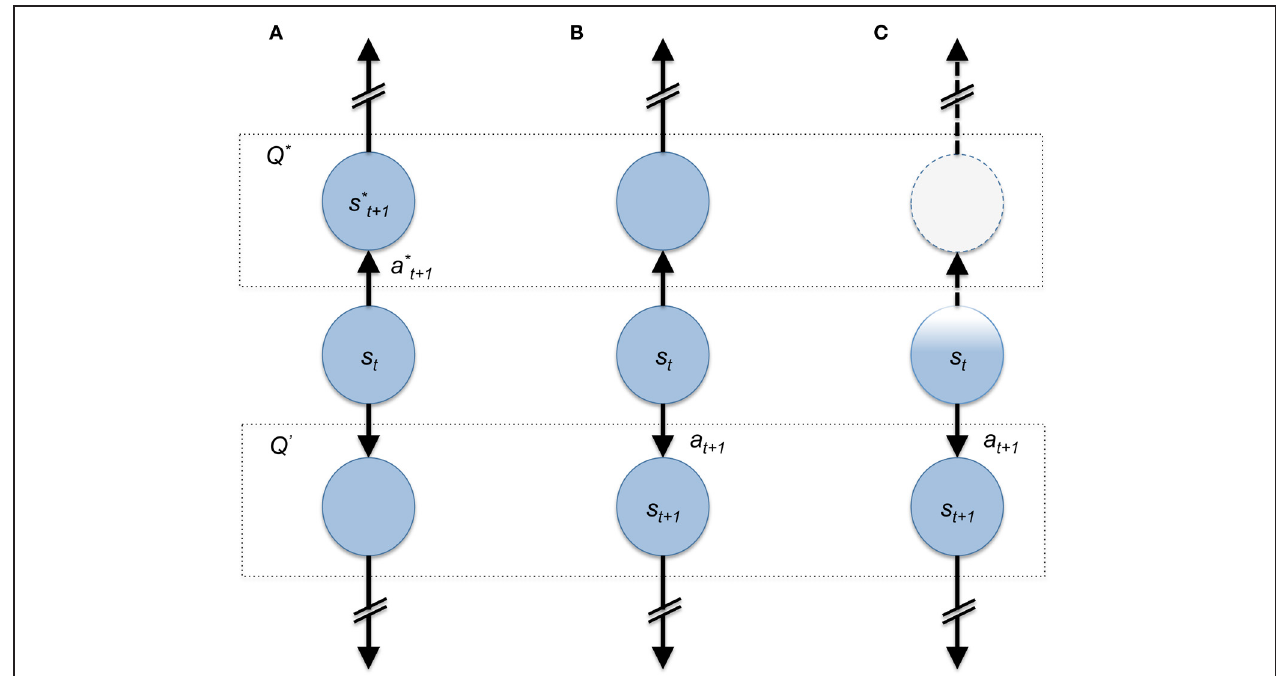
FIGURE 1 | Cartoon depiction of state-space representation of a simple choice problem. In all three panels an agent is in state s t at time t and must choose up or down. The dashed boxes with Q ∗ and Q (cid:3) represents the value of the up-state (value-maximizing) and down state (sub-optimal), respectively. In (A) the agent chooses a ∗ t + 1 and moves into the value